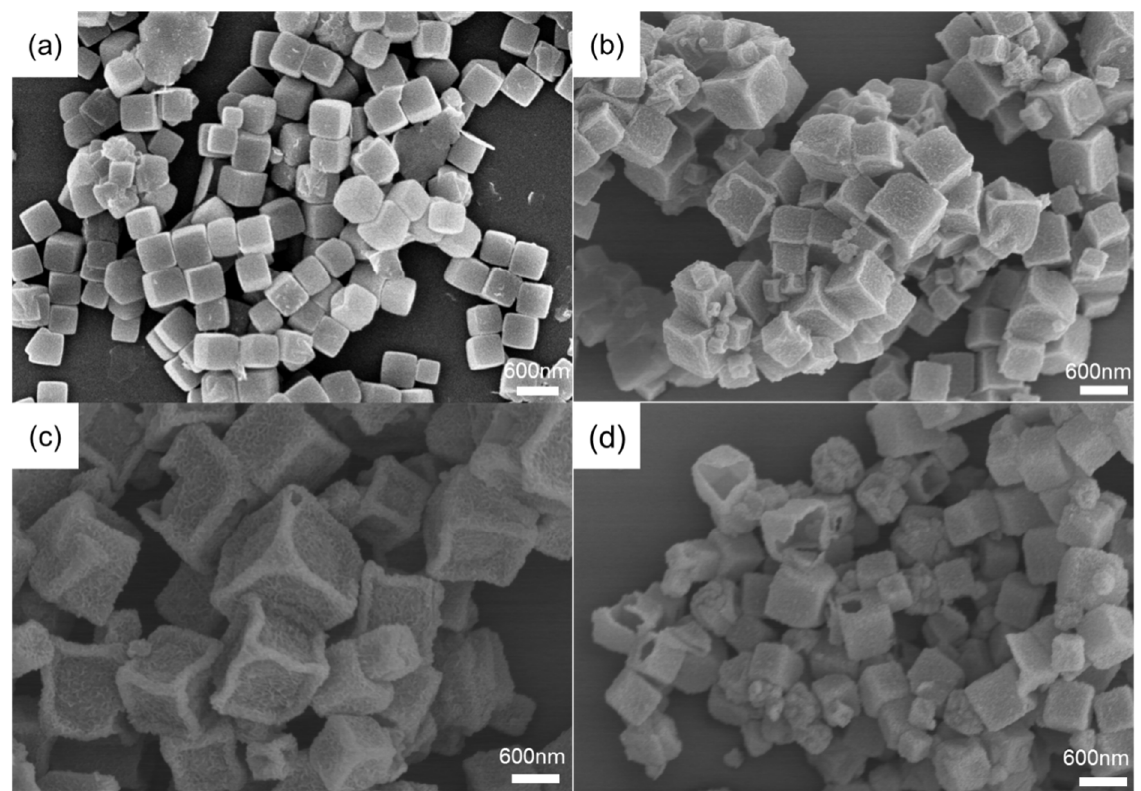
Figure 2. SEM of ZIF-67 precursor treated with different amounts of Ni(NO 3 ) 2 : ( a ) Pre-0, ( b ) Pre-16, ( c ) Pre-32, ( d ) Pre-64.